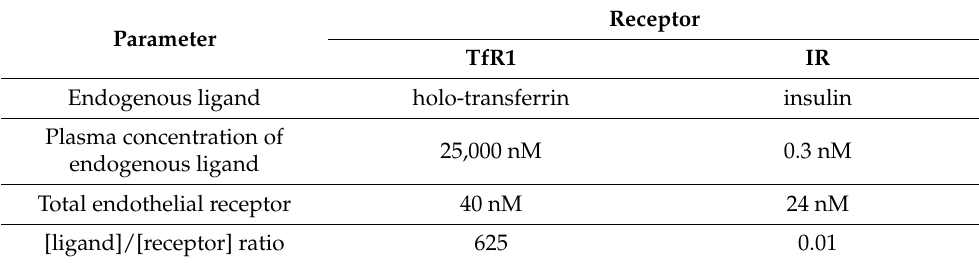
Table 9. Comparison of receptor concentration and endogenous plasma concentration for TfR1 and